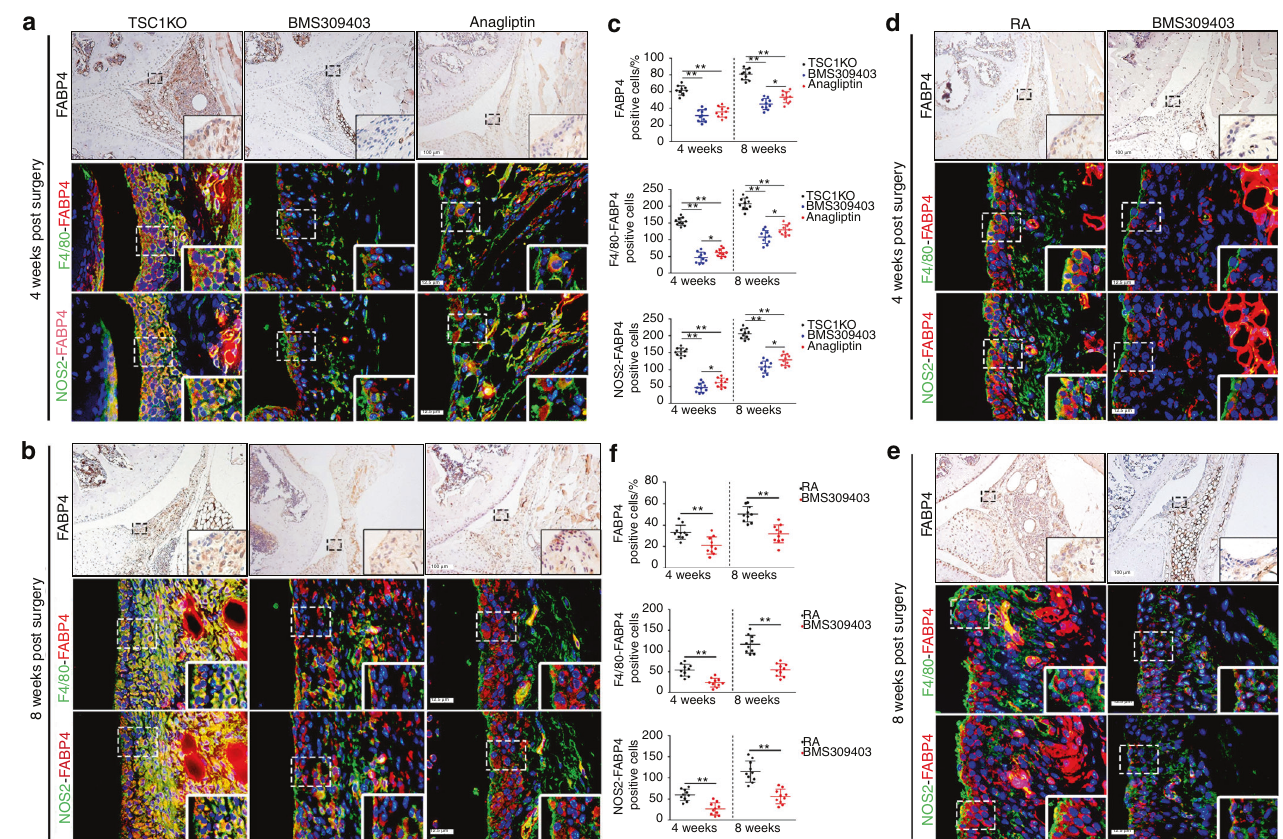
Fig. 6 BMS309403 and anagliptin reduce FABP4 expression in murine synovial macrophages. a – c Representative images and quanti fi cation of FABP4 immunohistochemical staining and coimmunostaining of FABP4 with F4/80 or NOS2 in the synovium of TSC1KO mice treated with vehicle, BMS309403 or anagliptin for 4 and 8 weeks after AIA modeling ( n = 10 per group). Scale bar: 12.5 µm and 100 µm. d – f Representative images and quanti fi cation of FABP4 immunohistochemical staining and coimmunostaining of FABP4 and F4/80 or NOS2 in the synovium